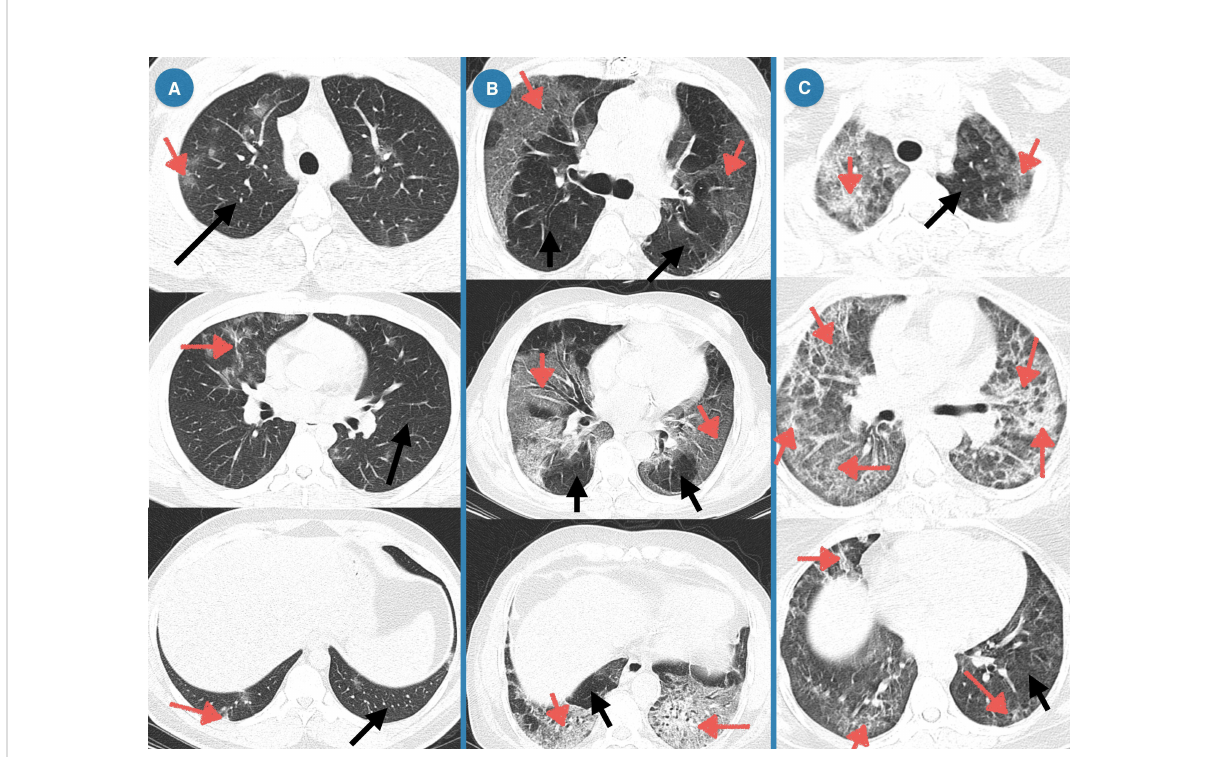
FIGURE 4 Lung CT of COVID-19 patients representing mild, moderate, and severe respiratory injury. (A) Mild, Multiple peripheral and central ground glass opacities (GGOs) in right upper lobe and left lower lobe; Band atelectasis in left lower lobe; (B) Moderate, Subpleural GGOs near costal and mediastinal pleura of both lungs, Consolidation with air-bronchogram in lower lobes of both lungs, multiple observations of band atelectasis; (C) Severe, Peripheral patchy GGOs, Diffuse and mostly peripheral GGOs, Multiple fi brotic bands.